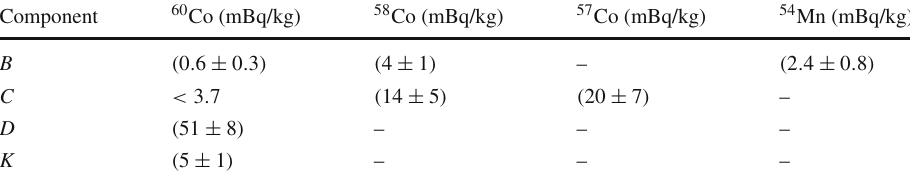
Table 2 Activity concentration – values and 90% C.L. upper limits – for short- and long-lived radioisotopes produced by cosmogenic activation in the materials of the detector